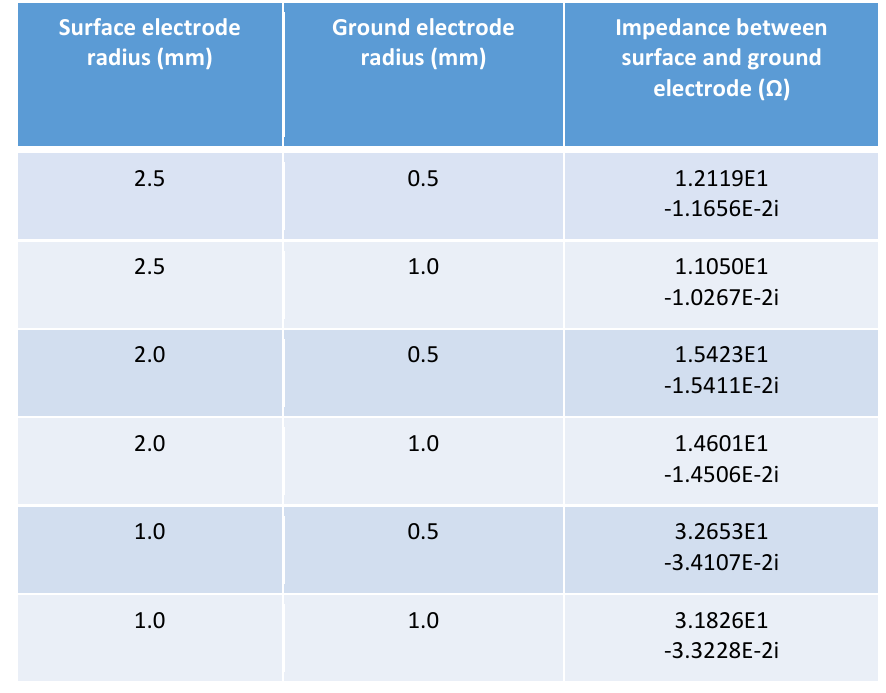
Table.1: Impedance measurements at 1 MHz with all the 28 surface electrodes excited simultaneously as terminals (7 electrodes in 4 rows)